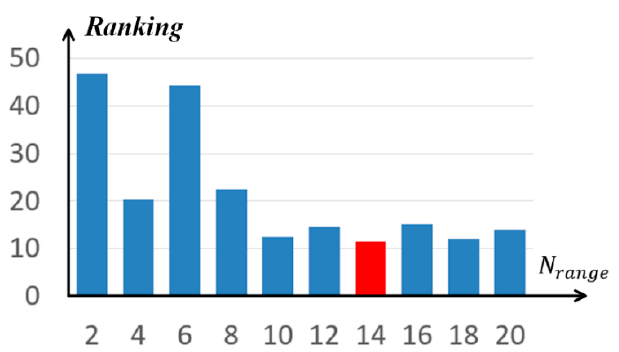
Figure 5. Ranking with various 𝑁 (cid:3045)(cid:3028)(cid:3041)(cid:3034)(cid:3032) on the Fayu temple dataset.